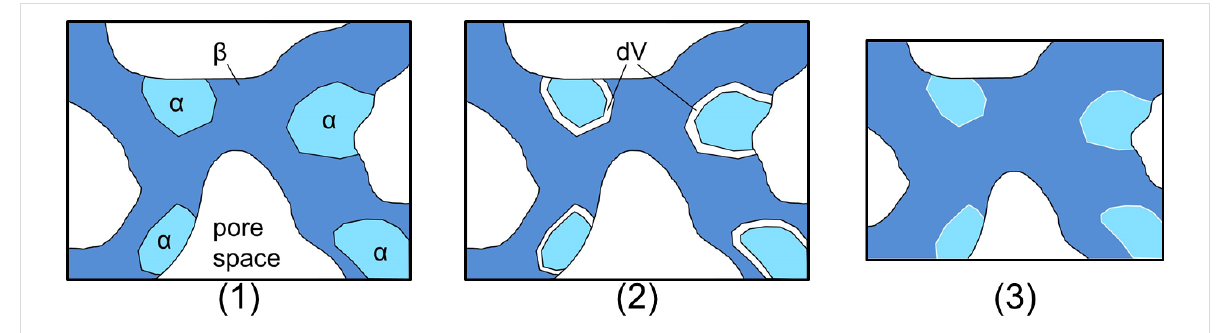
Figure 8: Schematic representation of the plasticity evolution during hydrogen desorption from nanoporous palladium hydride. In a saturated PdH β - phase PdH α -nuclei start to form (1) in the course of the desorption process. The strain mismatch (dV) of the two phases emerging during the phase transition (2) is then biased by the surface tension and leads to plastic deformation of the nanoporous structure (3) in radial direction, so that surface area is reduced. Note that the total palladium volume remains unchanged during this